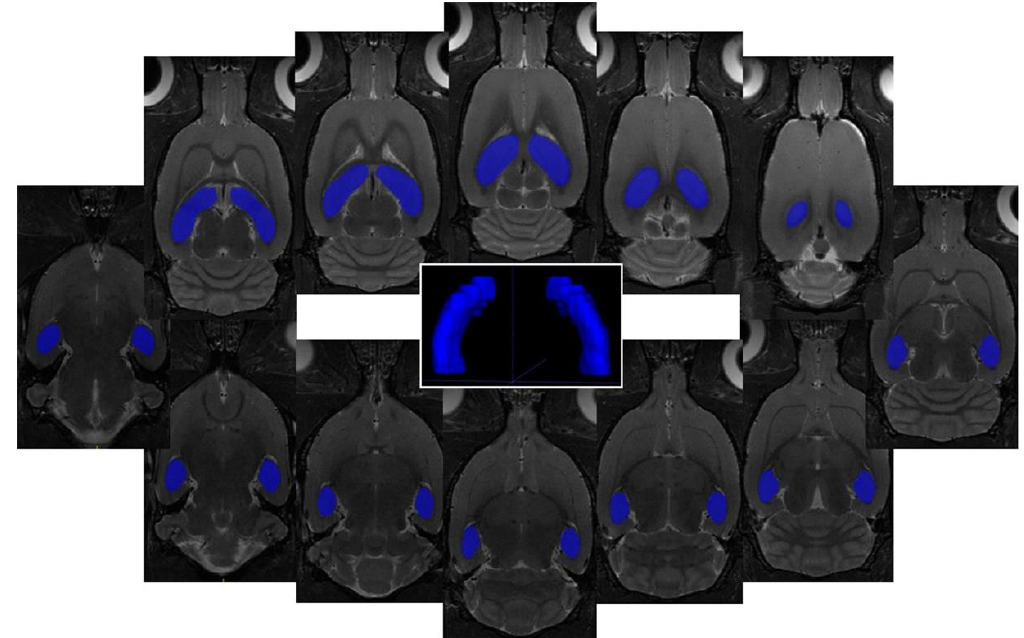
Figure 2. In vivo MRI volumetry of the hippocampus of the rat brain. On 12 consecutive coronal T 2 -weighted MRI (resolution 0.137 × 0.137 × 0.5 mm 3 ) is displayed representative regions of interest (ROIs) covering the hippocampus of the rat brain together with 3D visualization of target areas plotted by ITK-SNAP software (Version 3.4.0, US National Institutes of Health, USA).